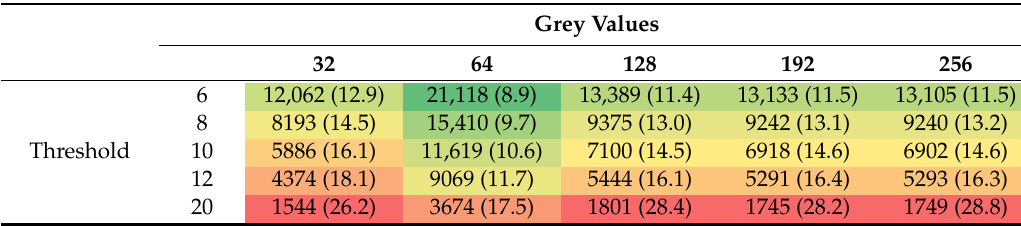
Table 1. Number of detections on the SSS mosaic under di ff erent frame conditions. Color scale indicates high values in green and low values in red. The average Euclidian distance [m] to the nearest neighbor is given in